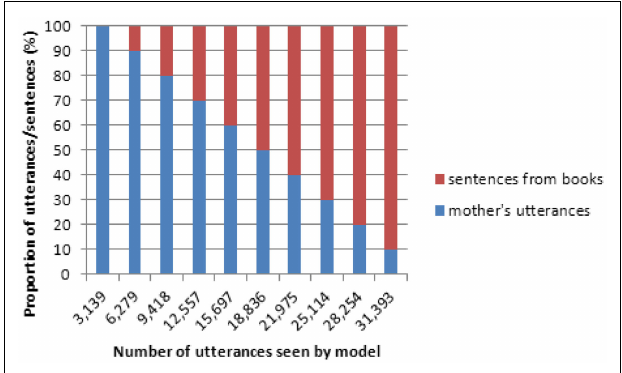
FIGURE 1 | Proportion of mother’s utterances and sentences from books that are used as input at each stage of the model’s learning, for the “Anne” dataset.